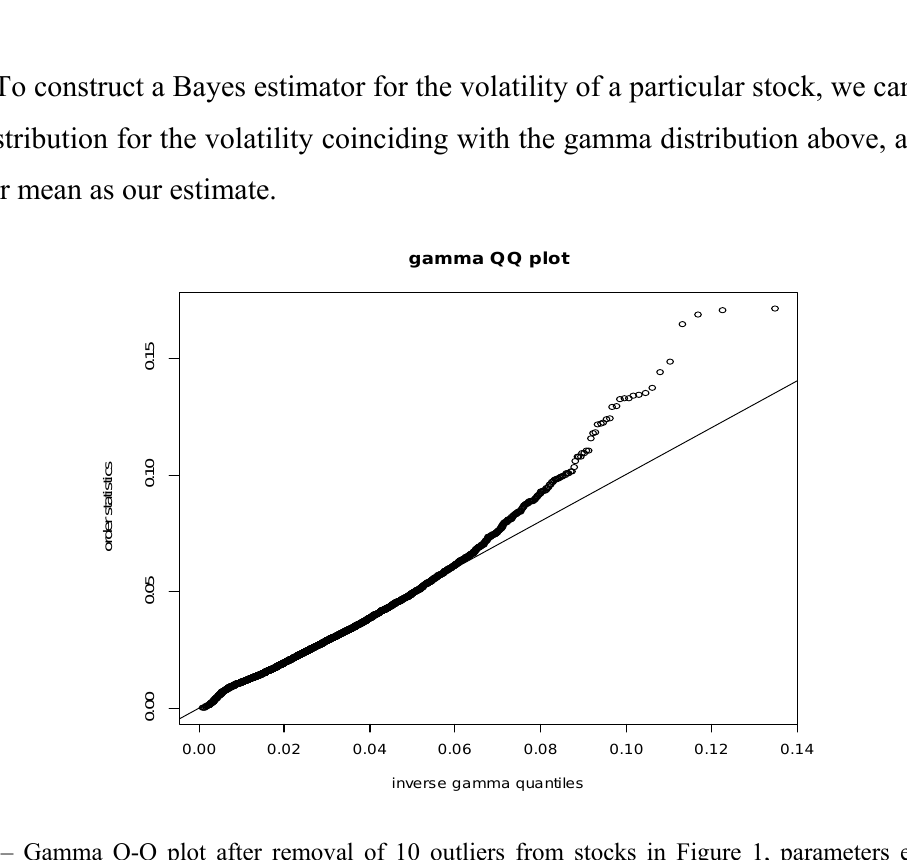
Figure 2 – Gamma Q-Q plot after removal of 10 outliers from stocks in Figure 1, parameters estimated by maximum